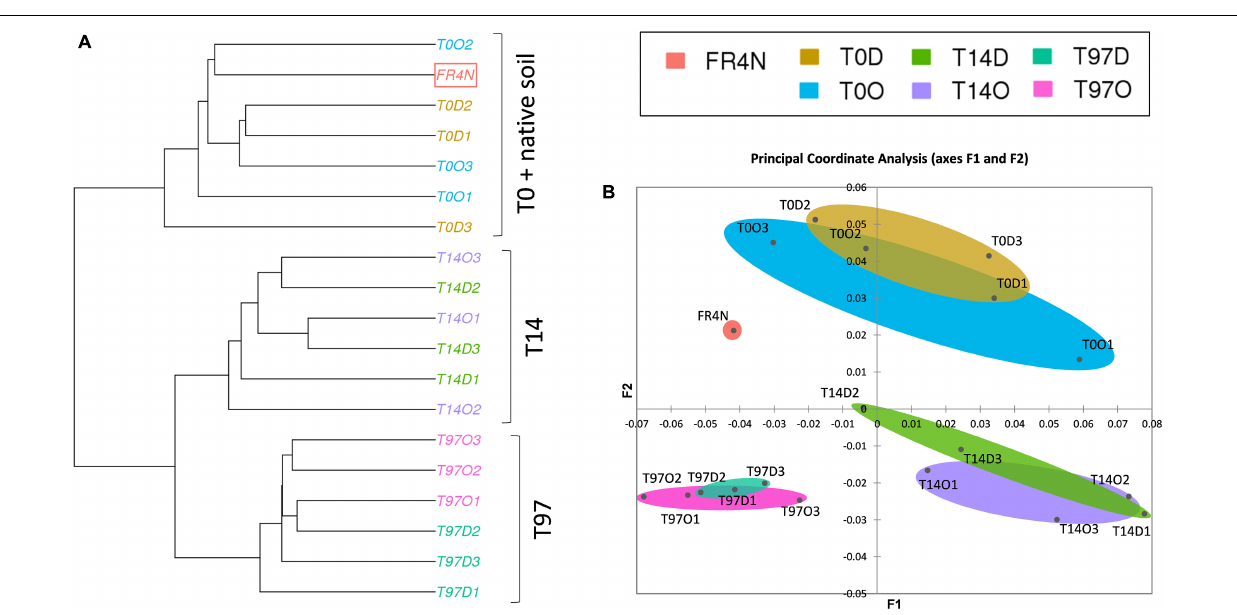
Frontiers in Microbiology |